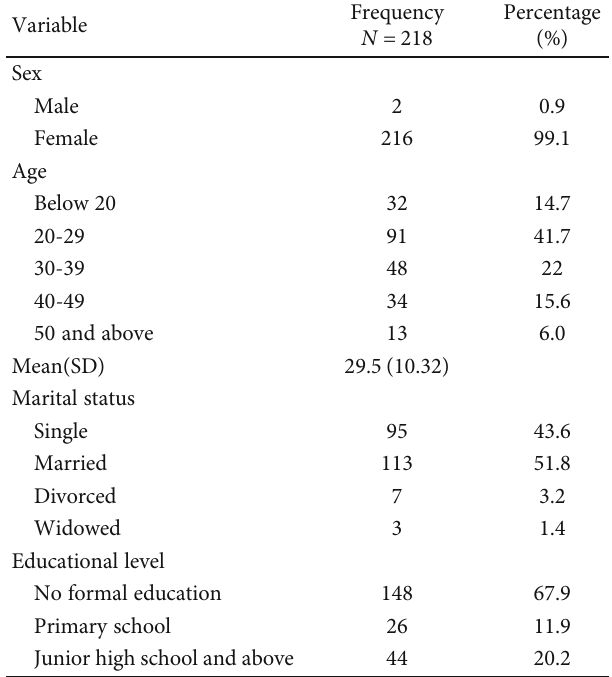
Table 1: Demographic characteristics of study